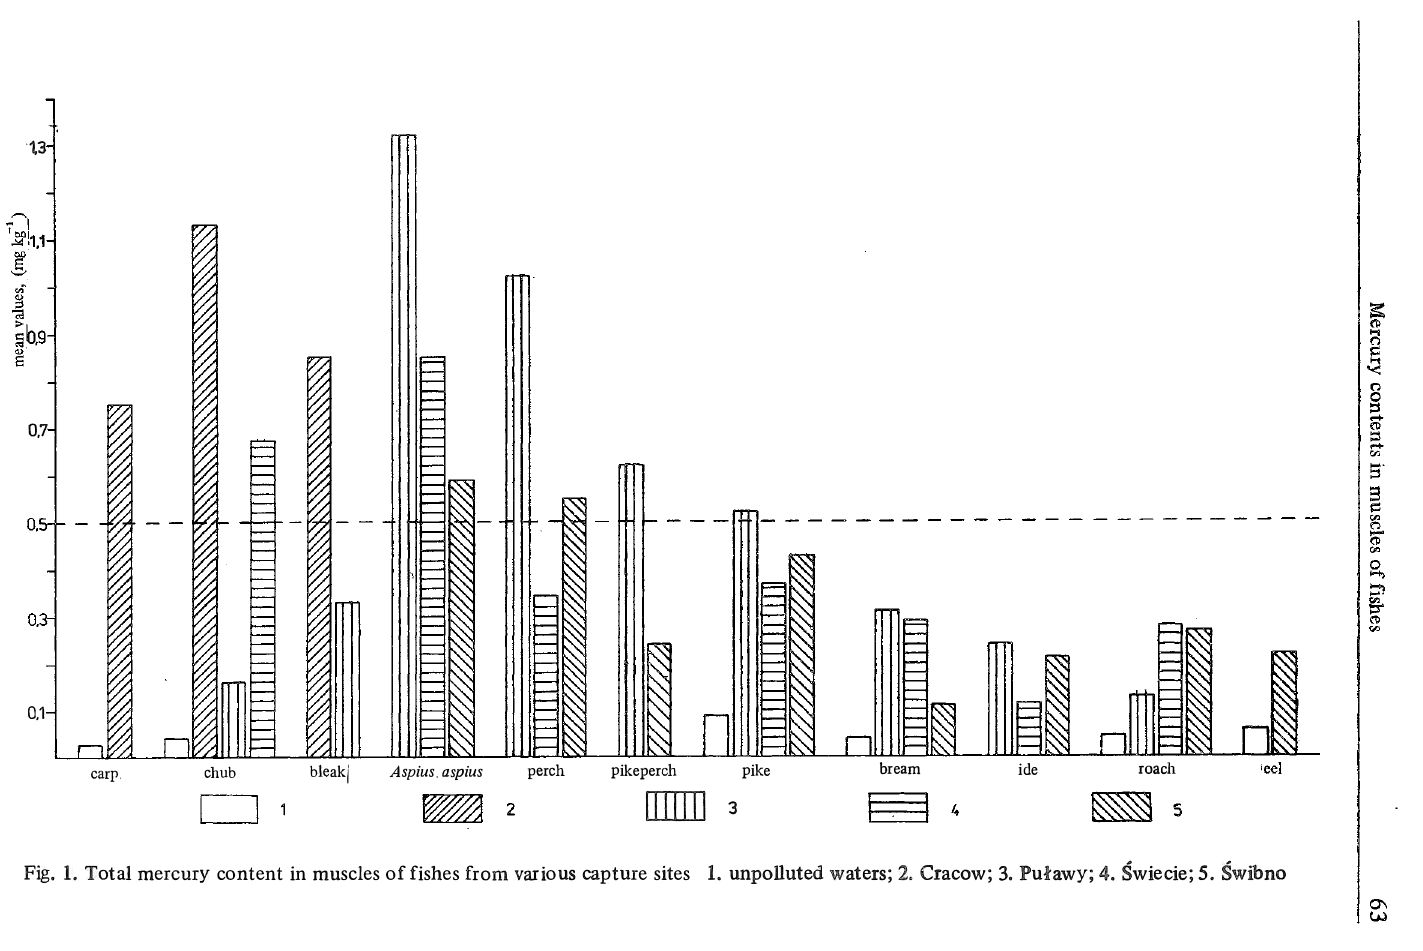
Fig. l. Total mercury content in muscles of fishes from various capture sites 1. unpolluted waters; 2. Cracow; 3. Pufawy; 4. Swiecie; 5.